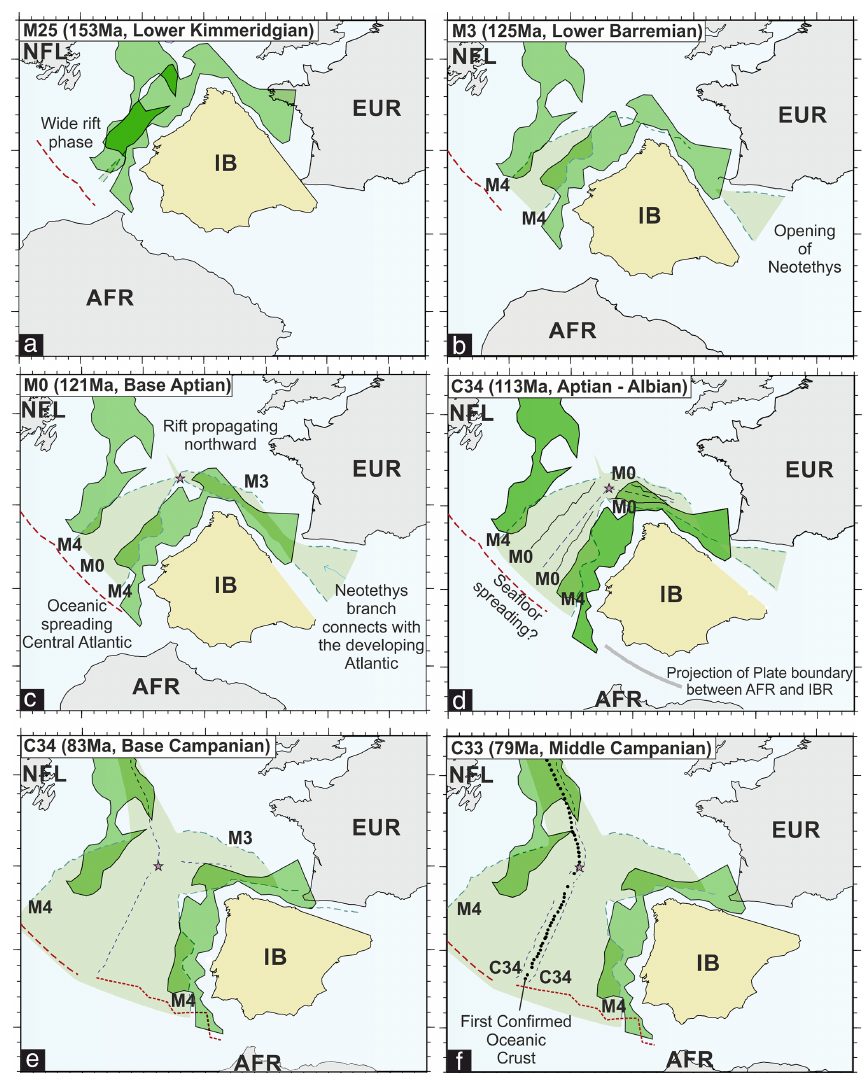
Figure 2. Six stages of development of the North Atlantic, from Late Jurassic to Late Cretaceous. Bright green envelopes show the maximum extent of the COTZ (Eagles et al., 2015). Light green shading shows oceanic lithosphere extent according to Sibuet et al. (2007) for the Atlantic and Sibuet et al. (2004) for the Bay of Biscay. Pink star: location of the triple junction between Eurasia–Iberia–North America. Adapted from Vissers and Meijer